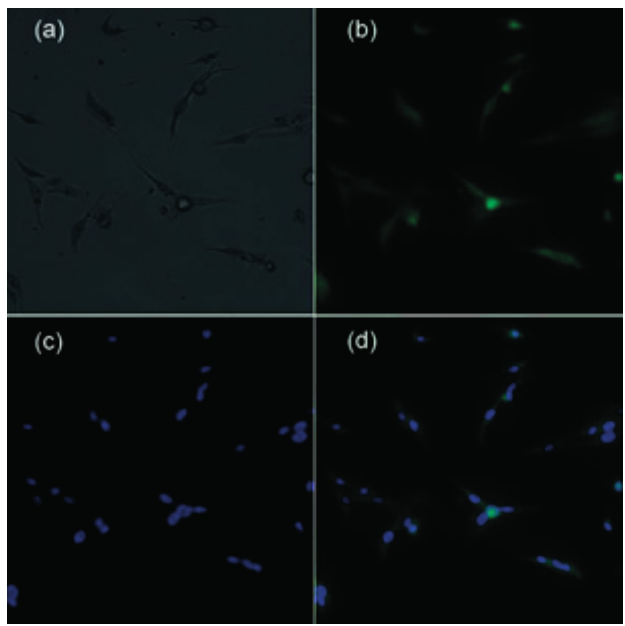
Figure 1. Fluorescent images of FITC-RGD4C β L stained C6. ( a ) C6, white light; ( b ) FITC-RGD4C β L, fluorescence of FITC; ( c ) DAPI; ( d ) overlay of ( b ) and ( c ). Immunofluorescent staining showed that the RGD4C β L adhered to the C6 cells, which